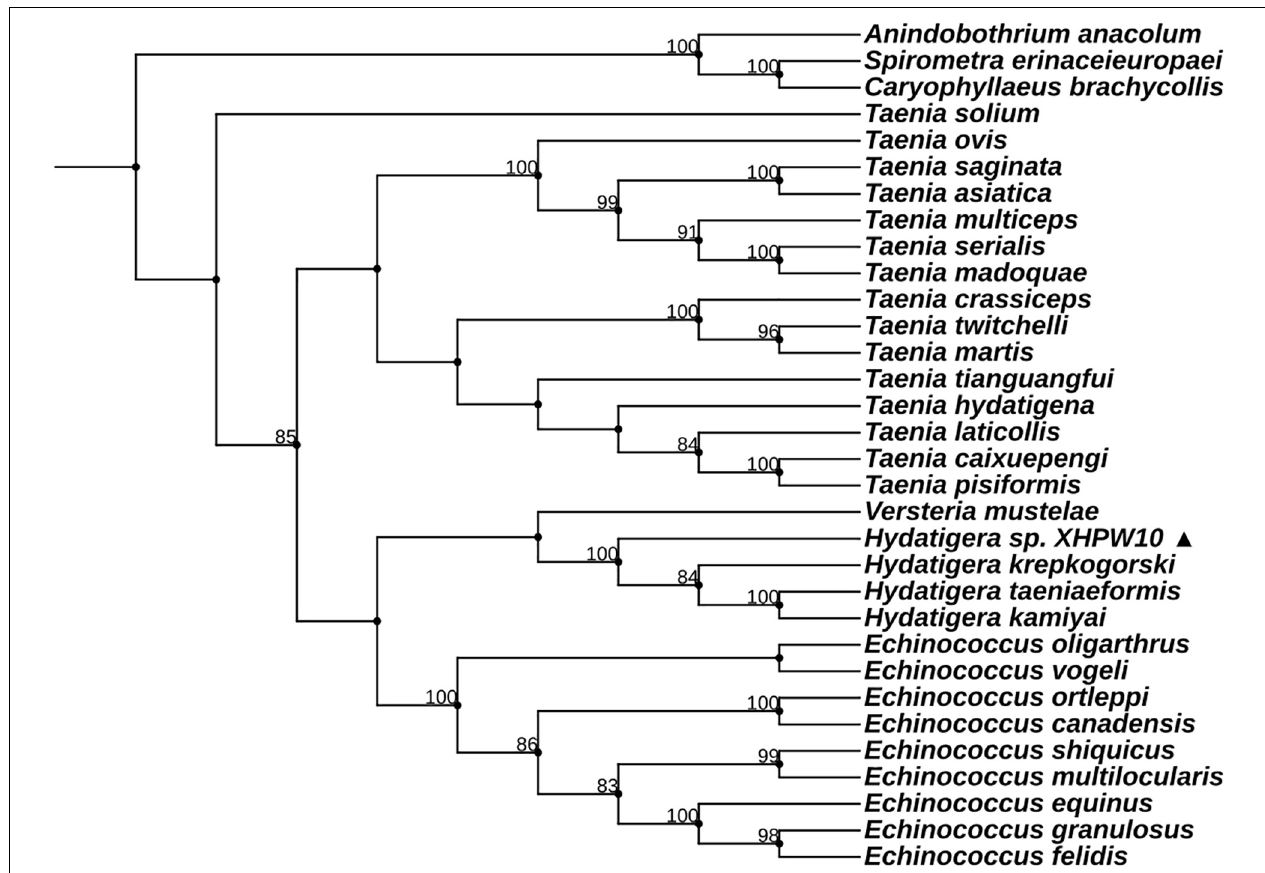
FIGURE 2 | Maximum likelihood analysis of 18S rDNA of family Taeniidae. The (cid:78) after the species name represents “putative new species.” The outgroup is the same as Figure 1 . Bootstrap frequency support values are stated only for nodes where >